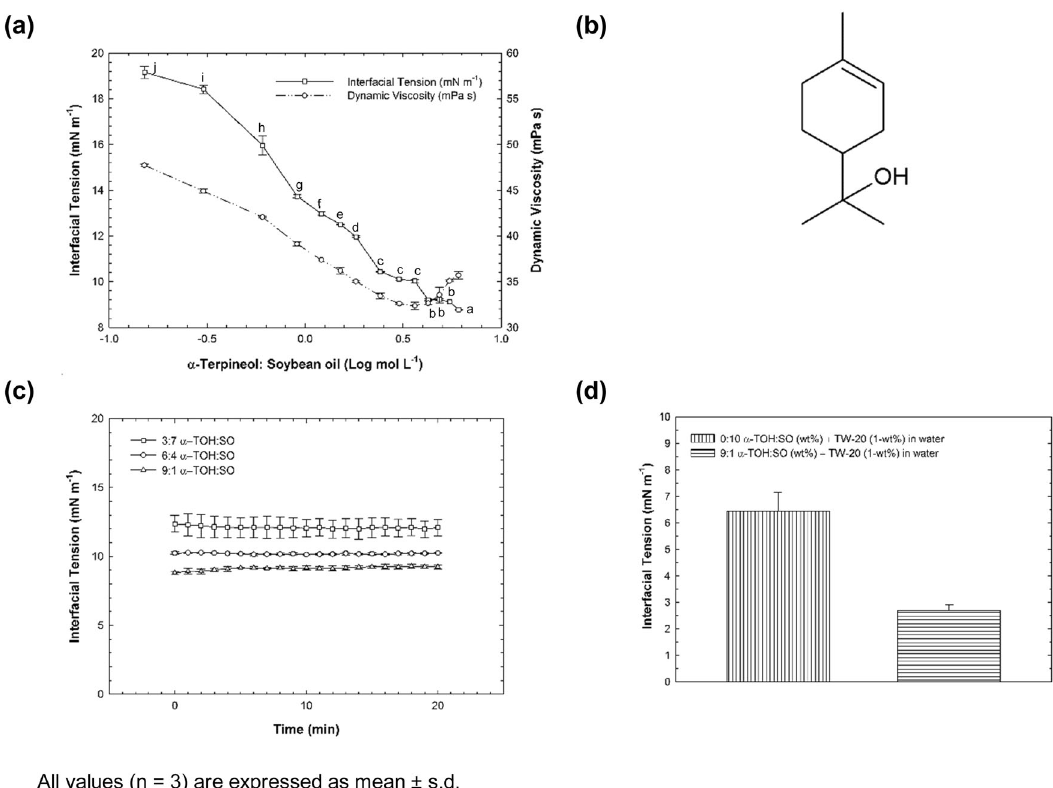
Fig. 1 Plots exhibiting the ability of α -terpineol to low the interfacial tension on the oil-water interface. (a ) Static interfacial tension (in absence of Tween ® 20, TW-20) for α -terpineol ( α -TOH) blended with different ratios of soybean oil (SO) and its correspondent dynamic viscosity. Values accompanied by different lowercase letters ( a – j ) indicate signi fi cant differences (Duncan Multiple Range Test; p < 0.05). ( b) Molecular structure of α -TOH (C 10 H 18 O; M w = 154.25 g mol − 1 ) showing its amphiphilic structure due to the polar and non-polar region. (c) Dynamic interfacial tension (in absence of TW-20) for some ratios of α -TOH: SO (3:7; 6:4; 9:1); ( d ) Static interfacial tension (in presence of TW-20) for α -TOH: SO (0:10; Table 1. Interfacial and thermodynamic property determined for α -terpineol ( α -TOH) on the liquid-liquid interface in this study. Parameter